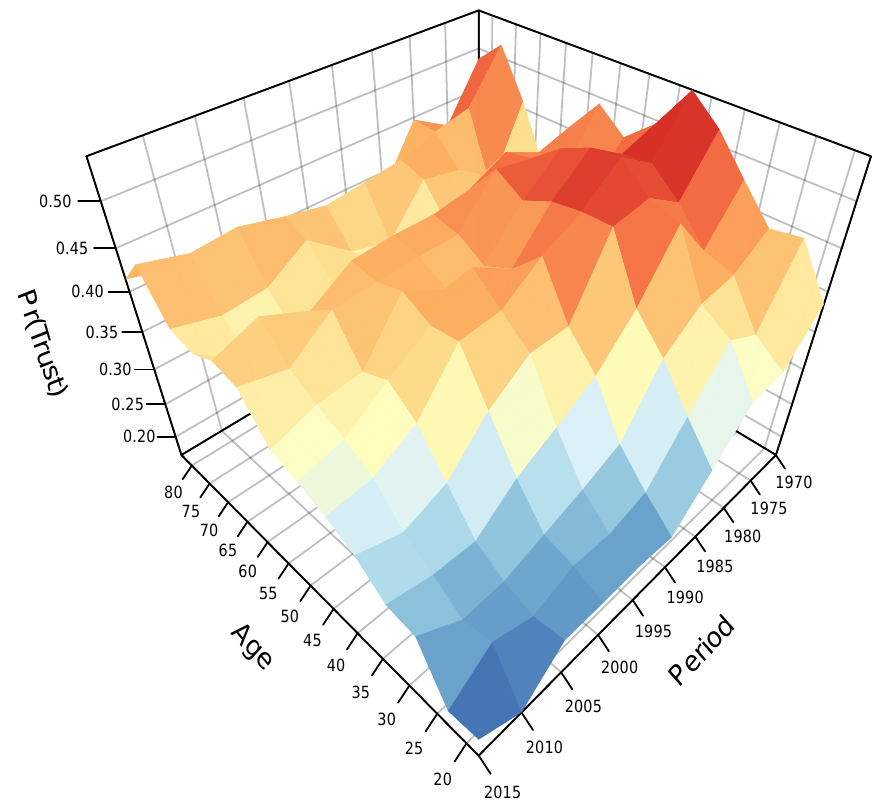
Figure 2: Three-dimensional age–period–cohort Lexis surface. Notes: Each cell gives the predicted probability of the outcome from a diachronic L-APC logistic regression model. Outcome is social trust, coded so that 1 = “can trust” while 0 = “can’t be too careful” or “depends.” Sample size R = 41, 126 respondents. Results adjusted using sampling